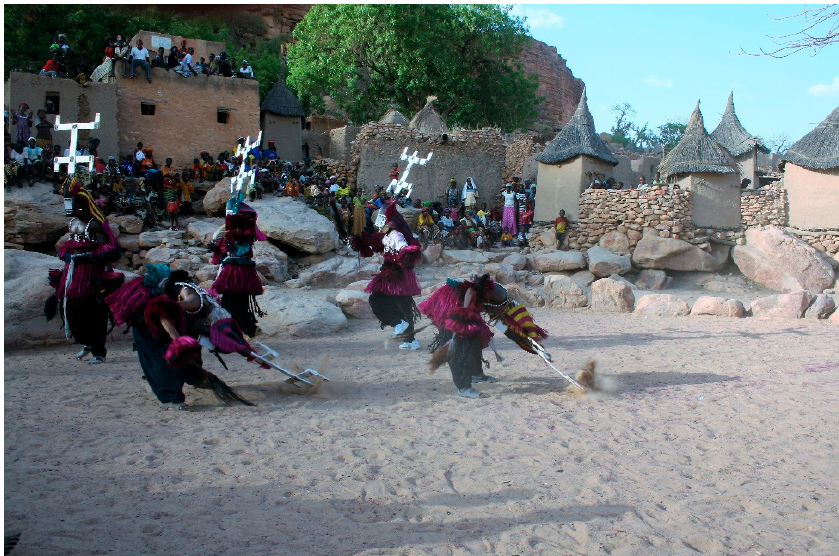
Figure 4. Kanaga dancing, Tireli 2008.